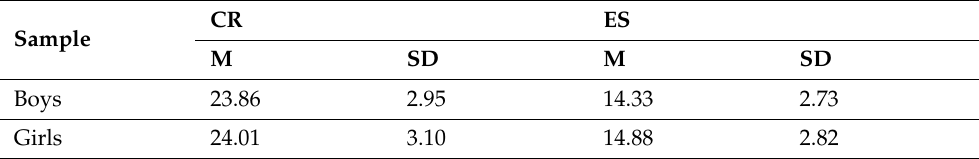
Table 8. Mean (M) and standard deviation (SD) of CR and ES in boys and girls. CR ES Sample M SD M SD Boys 23.86